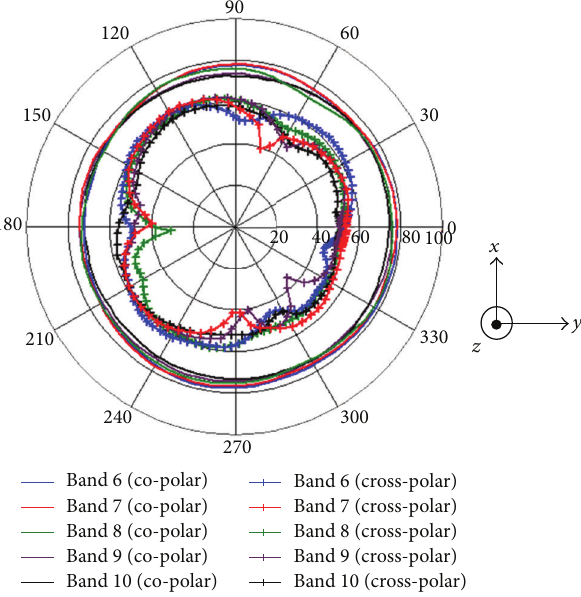
Figure 11: Measured H-plane radiation patterns (co-polar & cross- polar) at operating frequency, 𝑓 , for TMFDB25 with stubs 1, 2 at bands 10 to